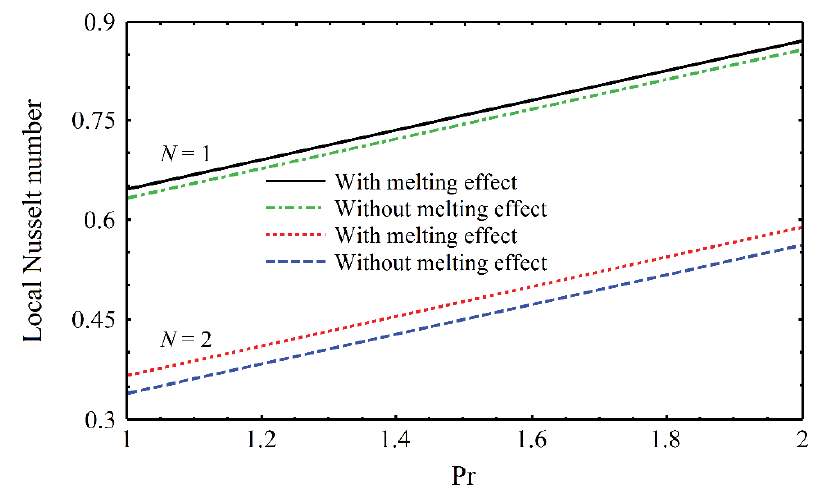
Figure 2. Effect of radiation parameter on the local Nusselt number with and without melting